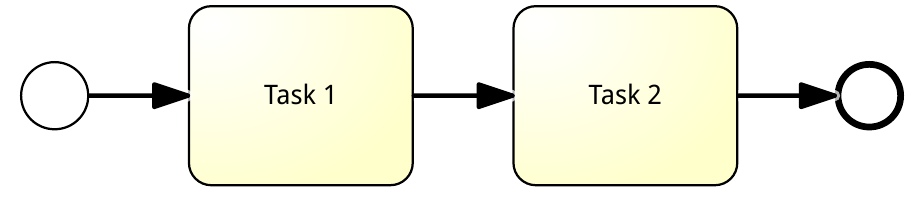
Figure 2. Example